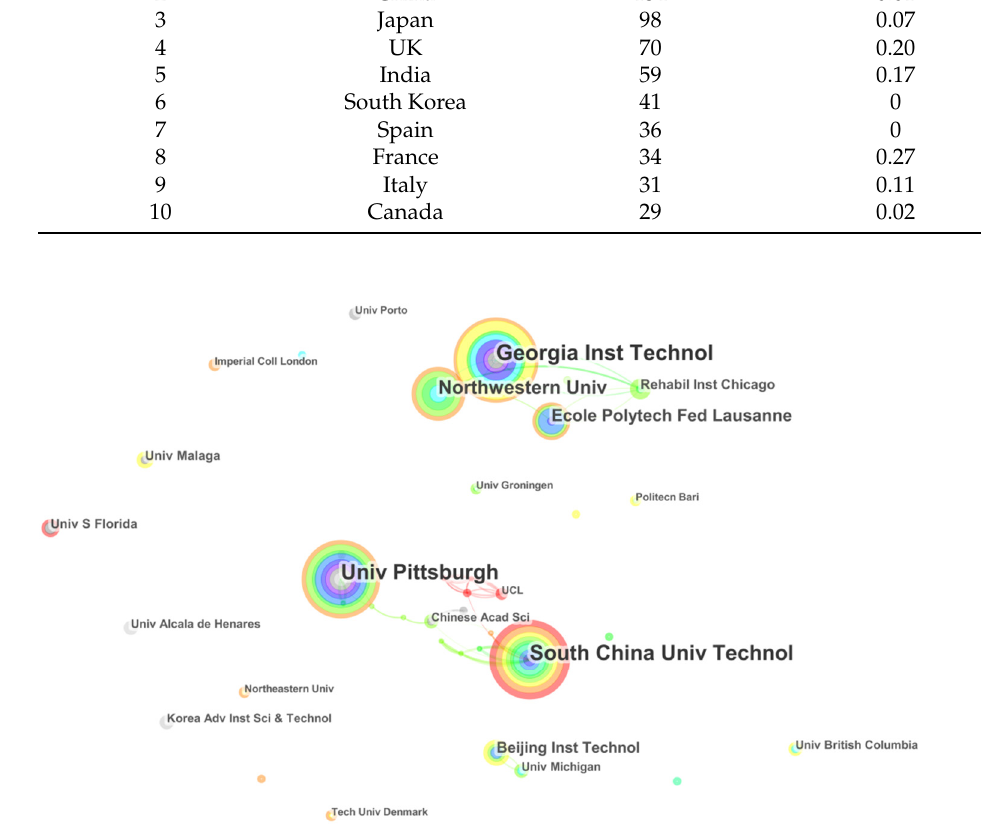
Figure 4. An institution collaboration map related to EPW HMI methodology research from 1998 to 2020. Table 4. Top 10 institutions involved in EPW HMI methodology research. Ranking Institution Country Publications Centrality 1